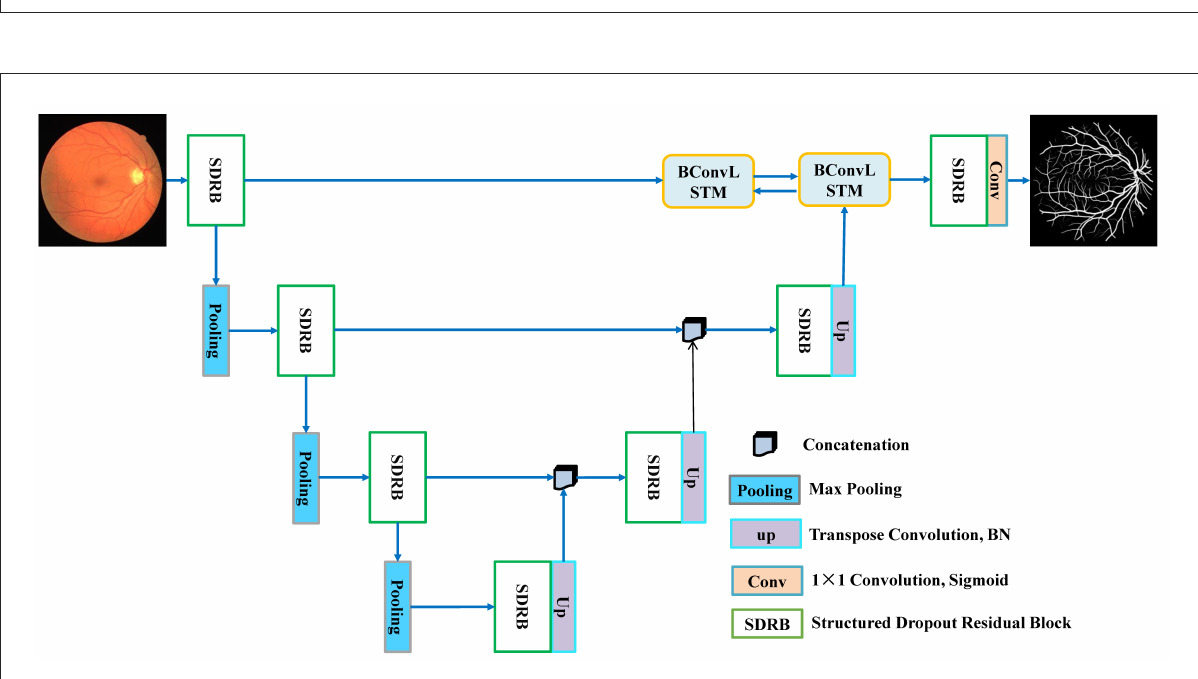
FIGURE2 The network architecture of